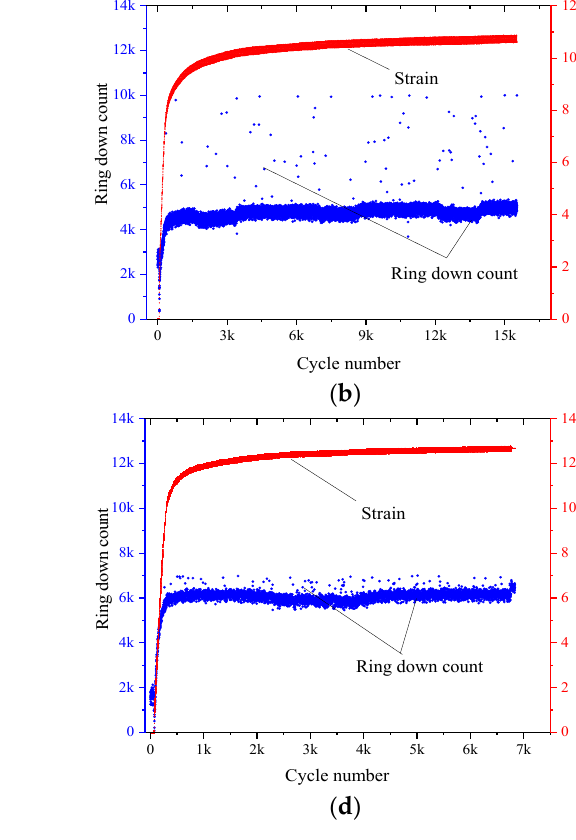
Figure 12. AE ring down count versus the number of cycles and strain at different k values: ( a ) k = 1.0; ( b ) k = 1.1; ( c ) k = 1.2; ( d ) k = 1.3 .